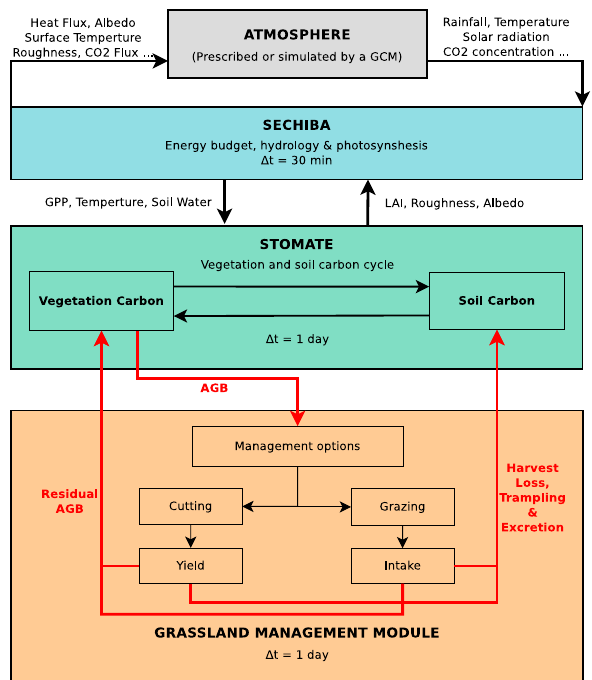
Fig. 1. Schematic of